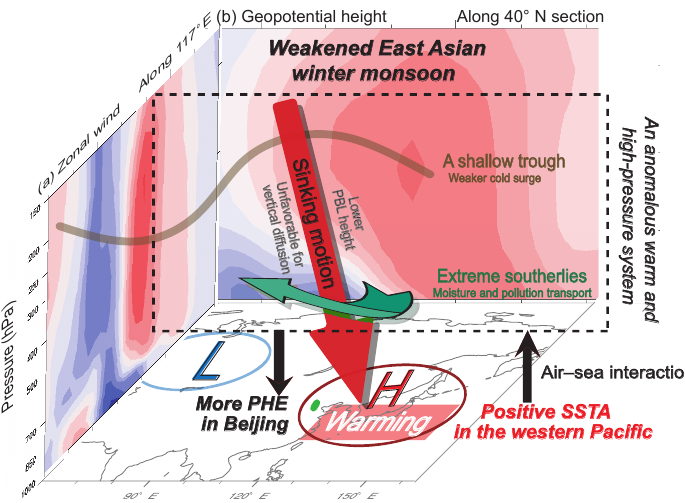
Figure 7. Schematic diagram summarizing the dynamic connection between the increased SSTA in the northwestern Pacific and the in- creasing PHE in Beijing through the weakening East Asian winter monsoon system. The cross sections are correlation coefficients between the meridional wind speed anomaly and vertical profile of (a) the zonal wind speed at 117 ◦ E and (b) the geopotential height at 40 ◦ N and 500hPa in winter from 1980 to 2016. The latitude and longitude coordinates of Beijing (green dot in base map) correspond to 40 ◦ N, 117 ◦ E, respectively. The letters “L” and “H” in the base map demonstrate the near-surface anomalous low- and high-pressure systems,